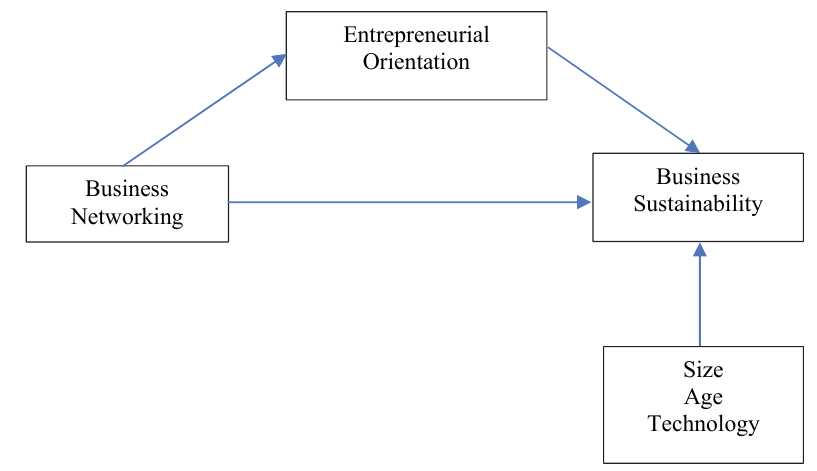
Fig. 1. Conceptual Framework of the